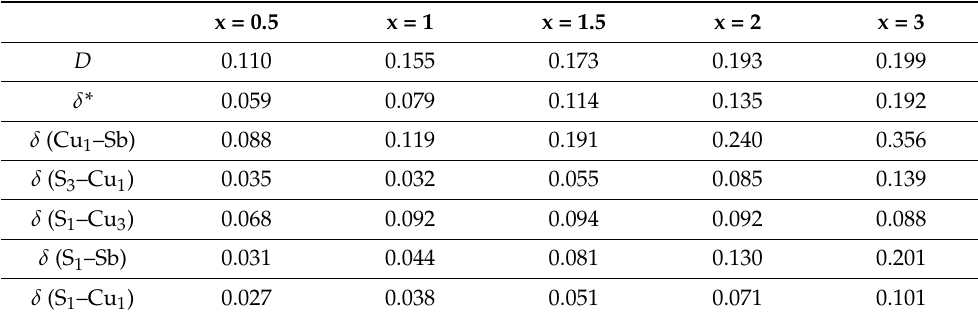
Table 1. Global instability index D , global bond strain index δ * and bond strain index δ calculated for Mg x6b Cu 12 Sb 4 S 13